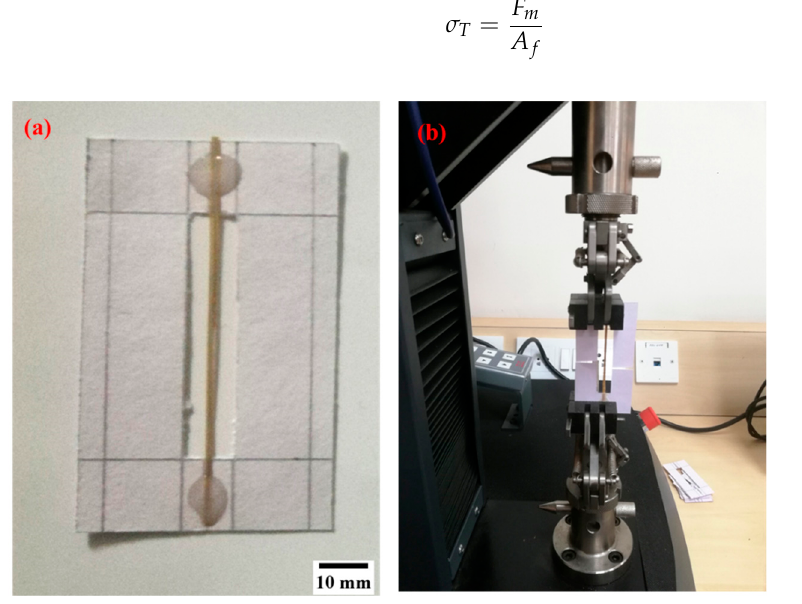
Figure 3. Tensile test of the RS fiber. ( a ) RS test sample; ( b ) Testing instrument.